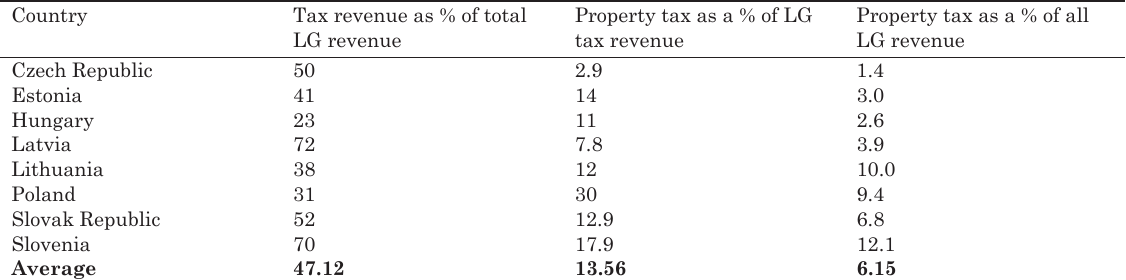
table 1. local government revenue sources in the Cee countries Country Tax revenue as % of total Property tax as a % of LG lG revenue tax revenue